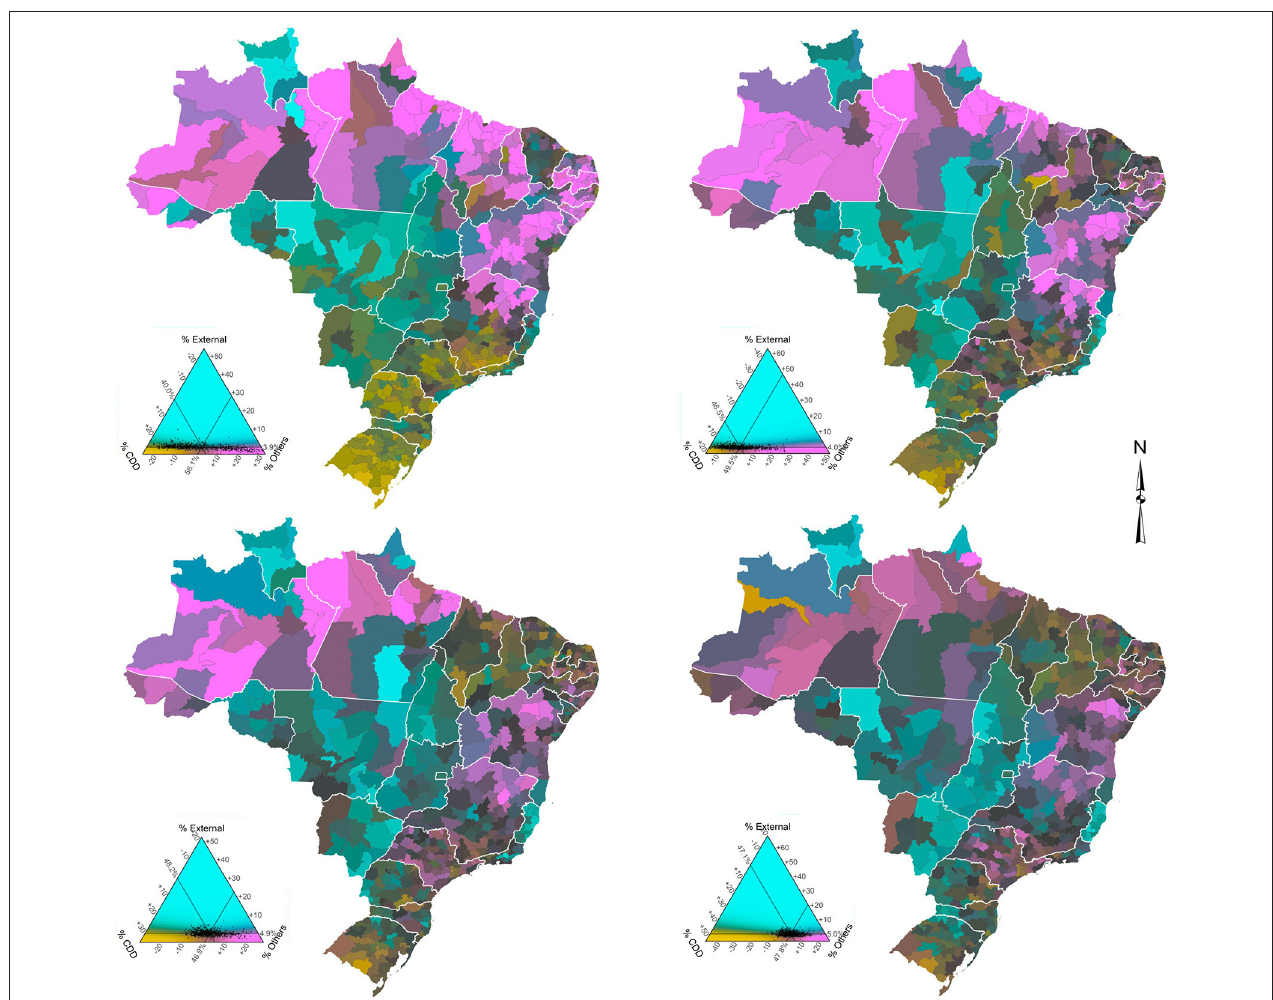
FIGURE 3 | Distribution of groups of causes of death by micro-regions, females, Brazil - time series 1998–2002 (top left), 2003–2007 (top right), 2008–2012 (bottom left), and 2013–2017 (bottom